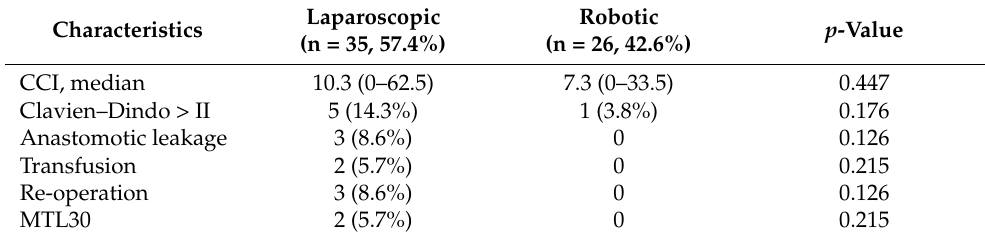
Table 3. Postoperative